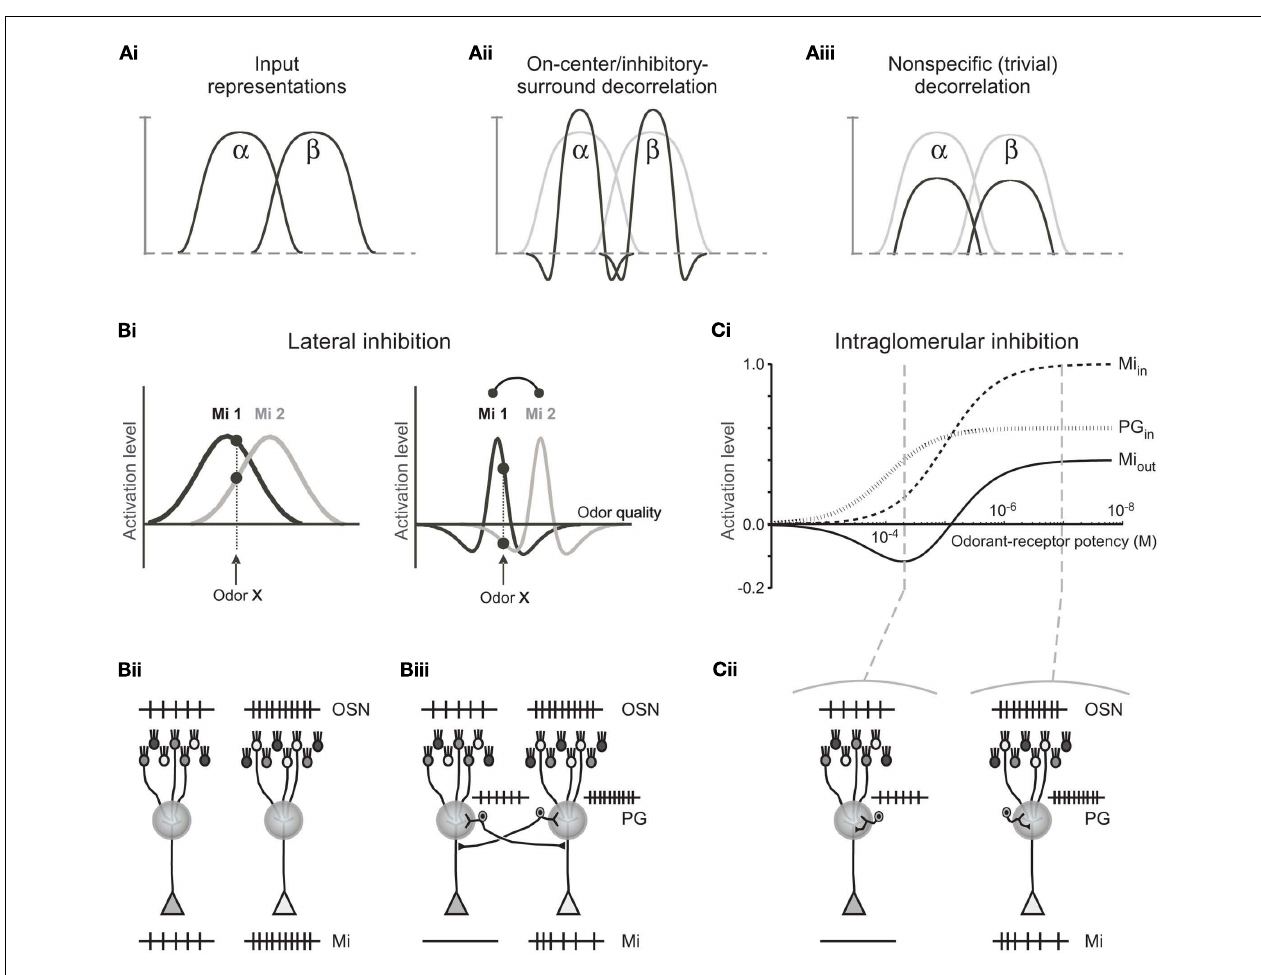
OSN population projecting to the glomerulus on the right. In the absence of inhibition, mitral cells (Mi) are activated in direct proportion to their constituent OSN populations. (iii) Schematic representation of the same two glomeruli and the same odorant presented as in (Bii) , with the addition of PG cells that also are activated in direct proportion to their OSN population and deliver lateral inhibition onto mitral cells in the other glomerulus.The mitral cell that is more weakly responsive to the odorant presented [corresponding to the dotted vertical line in (Bi) ] is silenced due to this lateral inhibitory input from the PG cell associated with the more strongly activated parent glomerulus. (C) Intraglomerular inhibition. (i) Tuning curves for mitral and periglomerular cells mapped onto an abscissa of odor ligand-receptor potency ( potency incorporates both ligand-receptor affinity and efficacy terms; for discussion of the effects of odor concentration on this relationship, see Cleland et al., 2007). Both mitral and periglomerular cells are excited by the odorant presented via the activity of their associated OSN populations (Mi in , PG in ); though PG cells are more sensitive to this common input (Gire and Schoppa, 2009). Inhibition of mitral cells by PG cells alters the mitral cell tuning curve (Mi out ), generating a Mexican-hat inhibitory surround in a metric space defined by odor quality. Figure adapted from Cleland and Sethupathy, 2006). (ii) Schematic representation of neuronal responses to a given odorant in the presence of intraglomerular PG-mediated inhibition of mitral cells.The odorant presented is the same as in (B) , exhibiting a stronger potency for the receptors expressed by the OSN population projecting to the glomerulus on the right [the two potencies correspond to those depicted by vertical lines in (Ci) ]. Periglomerular cells are activated in direct proportion to their constituent OSN populations, as in the lateral inhibitory case, whereas mitral cells receive both afferent excitation and intraglomerular inhibition, thereby exhibiting sharpened receptive fields with inhibitory surrounds.The mitral cell that is more weakly responsive to the odorant presented is silenced [compare to (Biii)